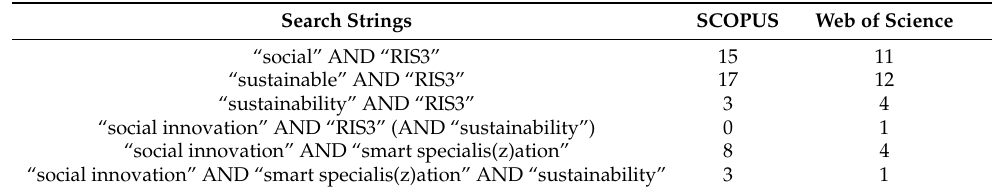
Table 2. Search strings and quantification of literature in SCOPUS and Web of Science